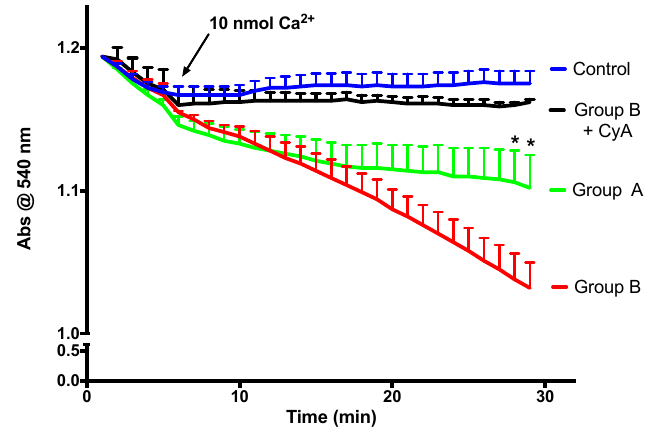
Figure 8. The effect of BBR addition in the preservation solution before ischemia on the susceptibility to the induction of mitochondrial permeability transition (mPT). Mitochondria were isolated from animals sacrificed after 12 h of hepatic exposure to preservation solution and 1 h of reperfusion, as described in the Materials and Methods Section. Control animals were sham operated. Mitochondrial swelling was spectrophotometrically evaluated by light scattering at 540 nm, as described in the Materials and Methods Section. Swelling was induced by the addition of calcium (10 nmol/mg protein). One condition was performed with the previous addition of 1 μ M of the mPT inhibitor cyclosporine A (CyA), to exclude any non-mPT-derived swelling. BBR pre-treatment (Group A) significantly reduced the susceptibility of I/R (Group B) mitochondria to calcium-provoked mPT induction. Traces represent the means ± SEM of an n = 4 different experiments. A two-way ANOVA with a Sidak post hoc test was conducted to assess the statistical significance between the control and the A and B groups. This test concluded a p < 0.05 statistical-significant effect of both time and experimental group. For any given time point, * indicates a p < 0.05 difference vs. I/R.